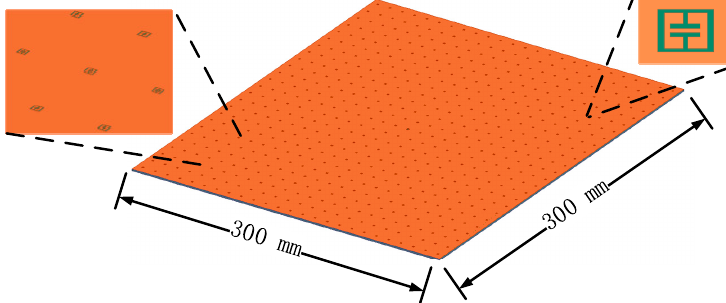
Figure 5. The complementary electric coupled (CELC) array in the Ansoft HFSS simulation.